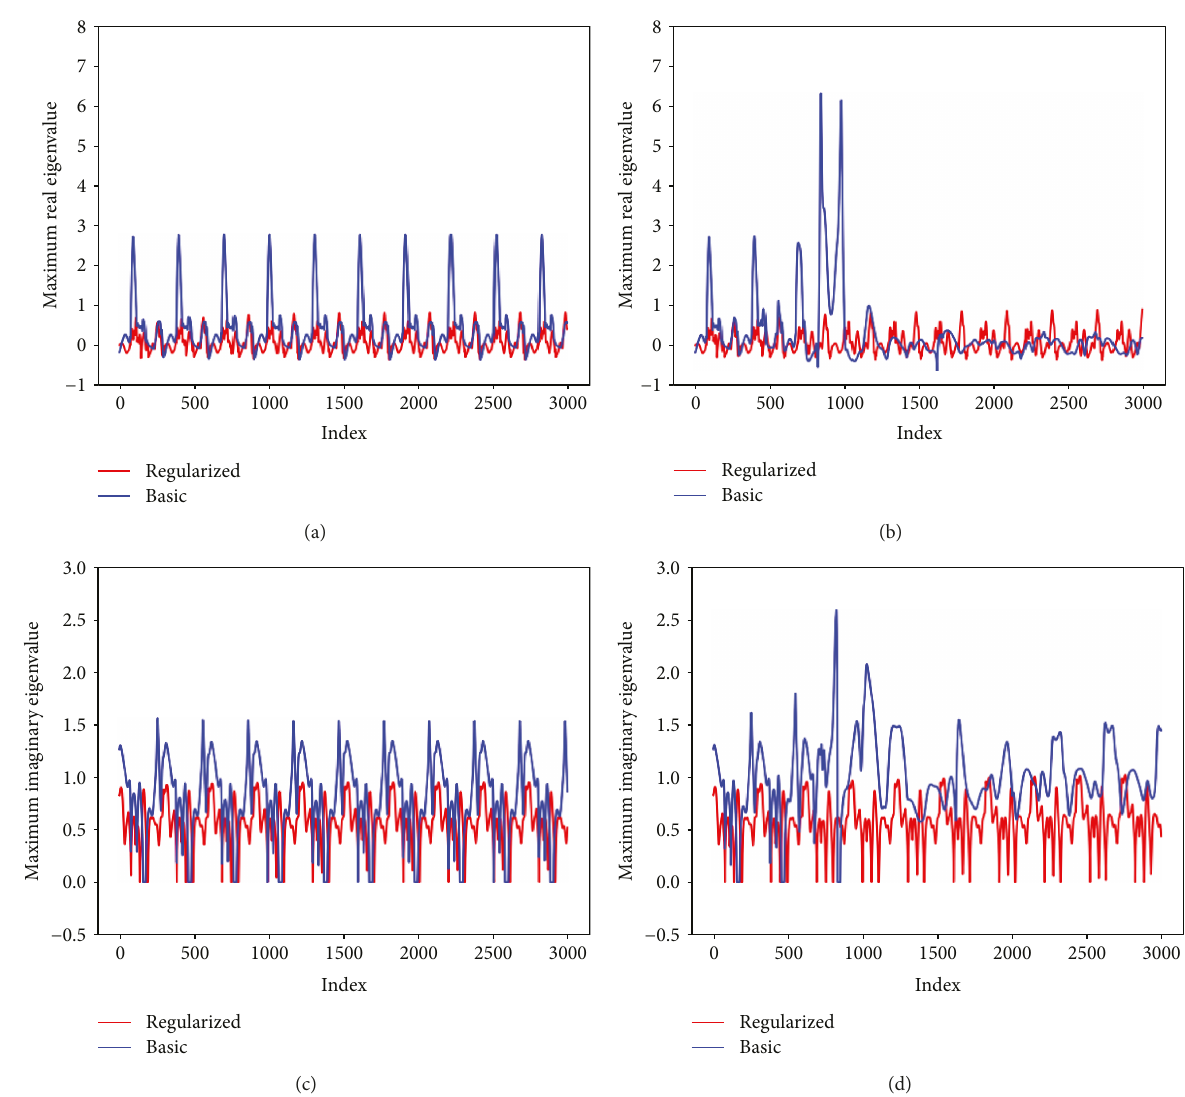
Figure 17: Flow in a cylinder wake. Comparison of eigenvalue of the Jacobian between regularized and basic model on testing data. (a, b) Maximal real eigenvalue. (c, d) Maximal imaginary eigenvalue. (a, c) A priori. (b, d) A